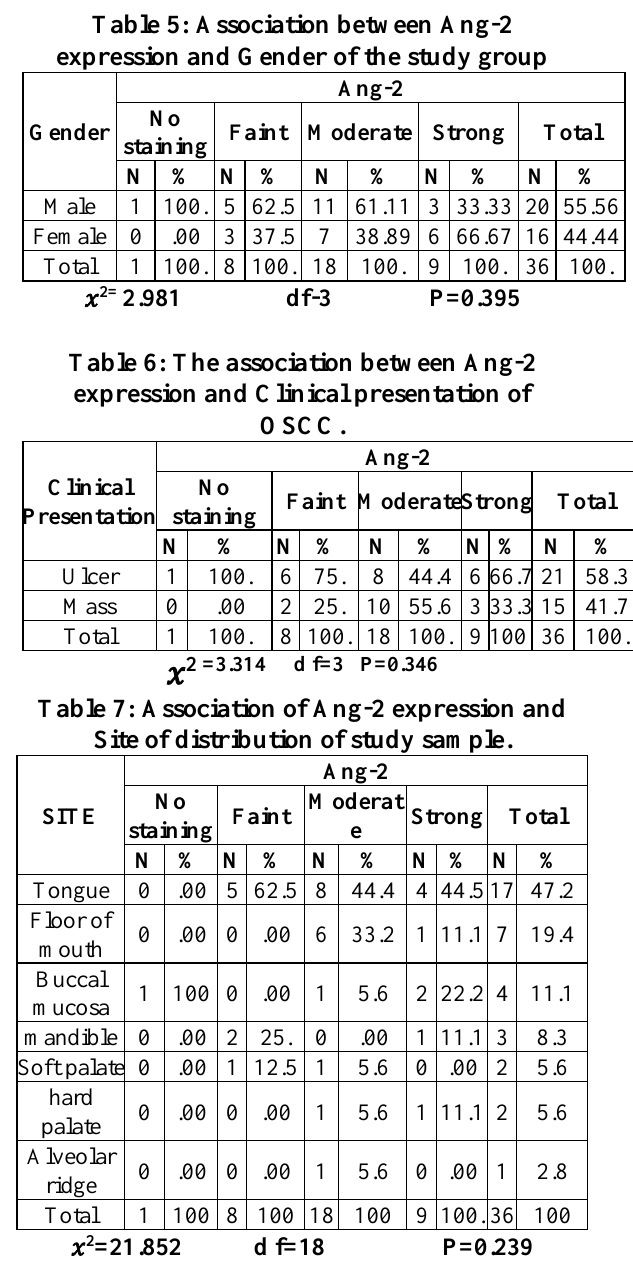
Table (8) showed the association between Ang-2 expression and histopathological grade of OSCC of the study sample, the association was found to be statistically significant(P